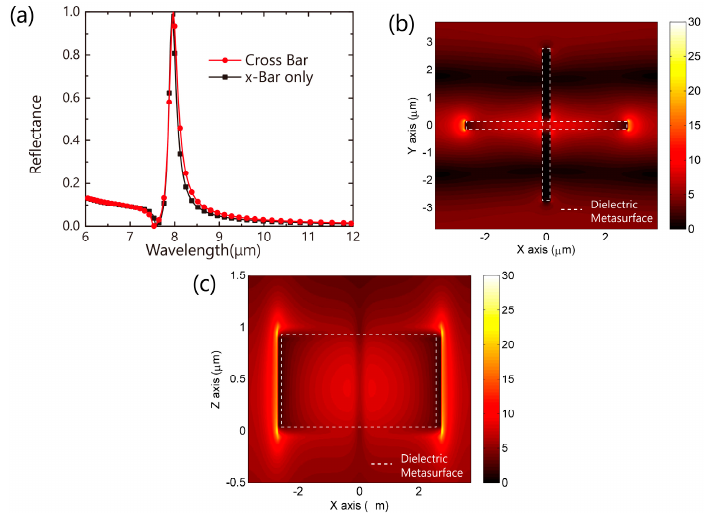
Figure 2. ( a ) The reflectance spectra of the dielectric metasurfaces (cross bar and x -bar only) without metal film., A Fano resonance is observed with the full-width at half-maximum (FWHM) 220 nm. The E-field distribution of the metasurface in x - y plane ( b ) and x - z plane ( c ) at 7.98 μ m. There is a strong E-field localization at the ends of the horizontal bar.